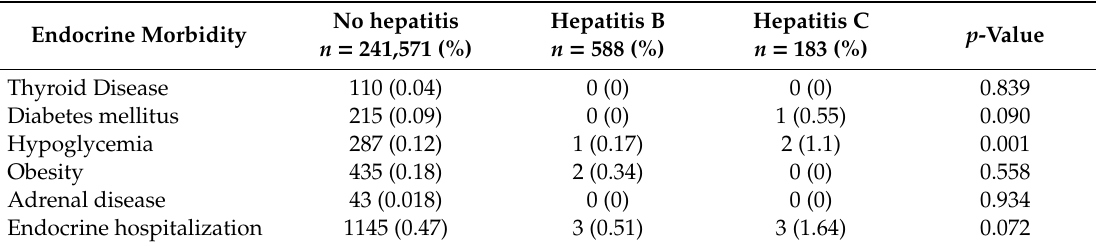
Table 2. Long-term endocrine morbidities and hospitalization in children (up to the age of 18 years) born to chronic hepatitis-carrier mothers compared with non-carriers.